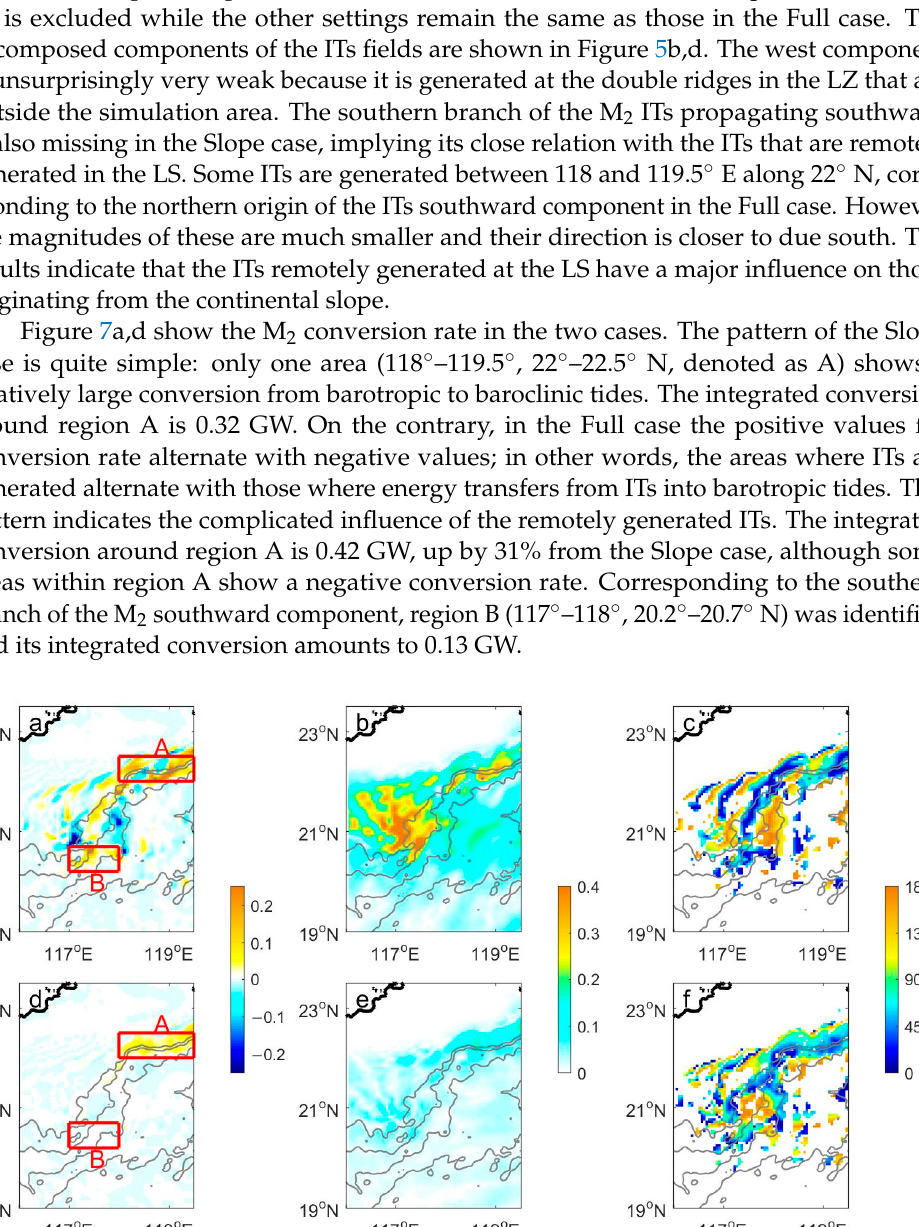
Figure 7. The M 2 tide ( a , d ) conversion rates (shading, unit: W/m 2 ), ( b , e ) the bottom pressure perturbation amplitudes (shading, unit: kPa), and ( c , f ) the phase differences between the pressure perturbation and vertical velocity at the sea floor (shading, unit: degrees) in ( a – c ) the Full case and ( d – f ) the Slope case. Only areas with a conversion greater than 0.01 W/m 2 are shown for clarity. The gray lines indicate isobathic contours of − 3000, − 2000, − 1000, and − 500 m.